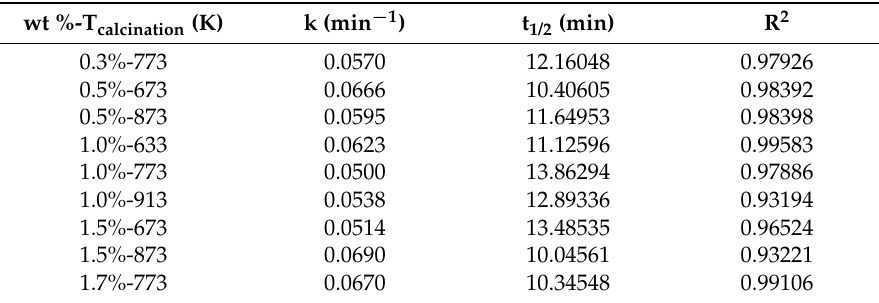
Table 3. Half-life t 1/2 , first-order reaction rate constant results.